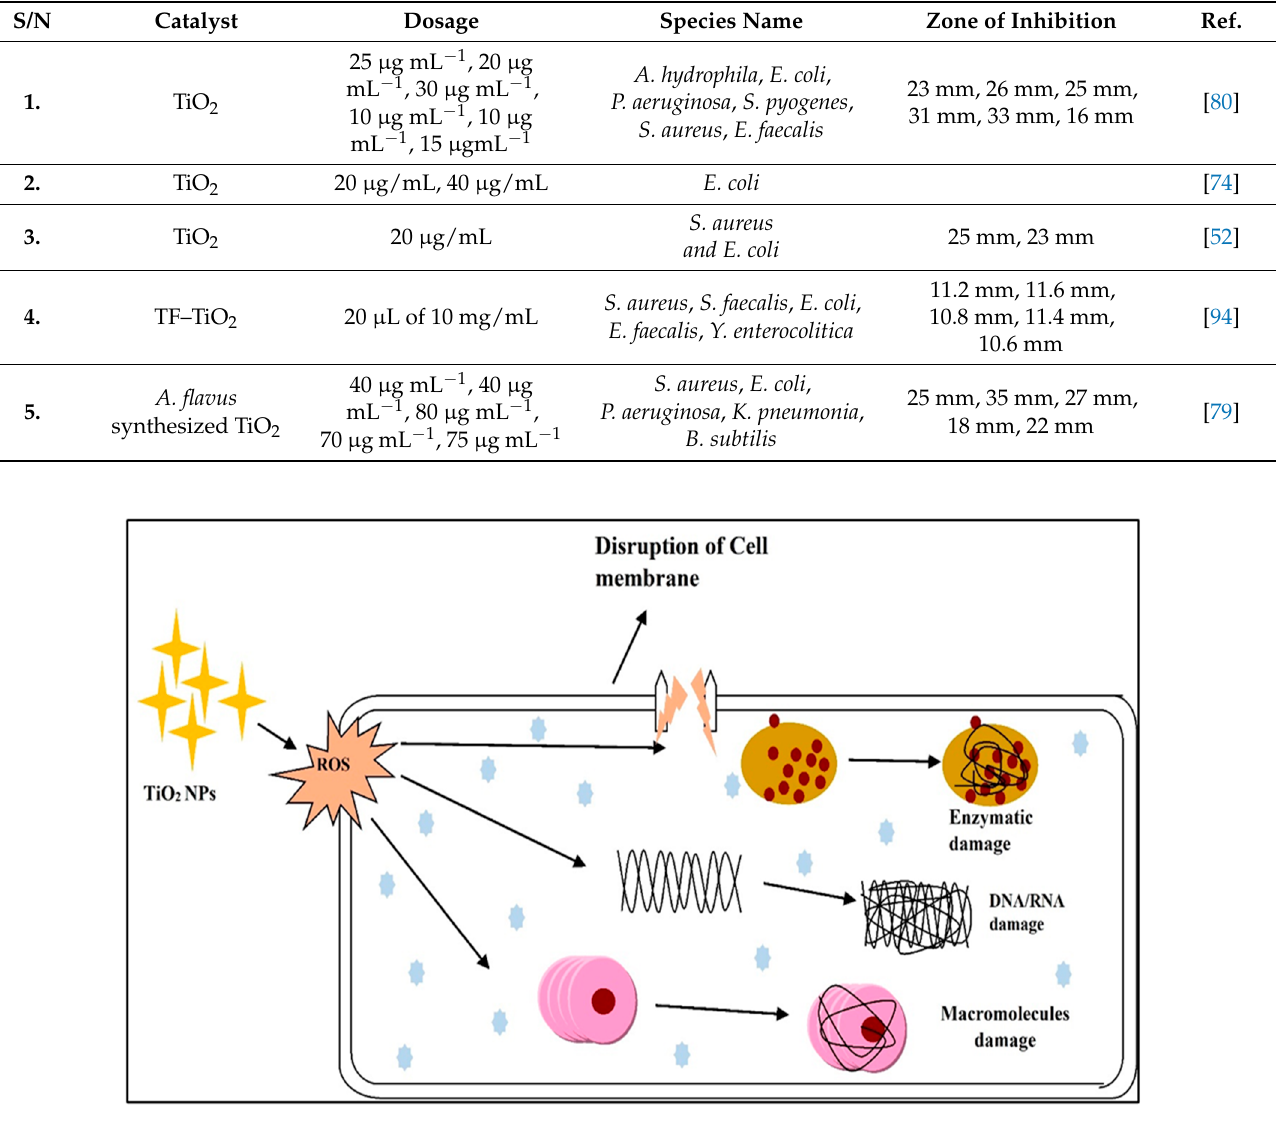
Figure 8. The impact of TiO 2 NPs on microbes is depicted as a proposed pathway. Table 4. Antimicrobial effect of Titanium dioxide NPs using different